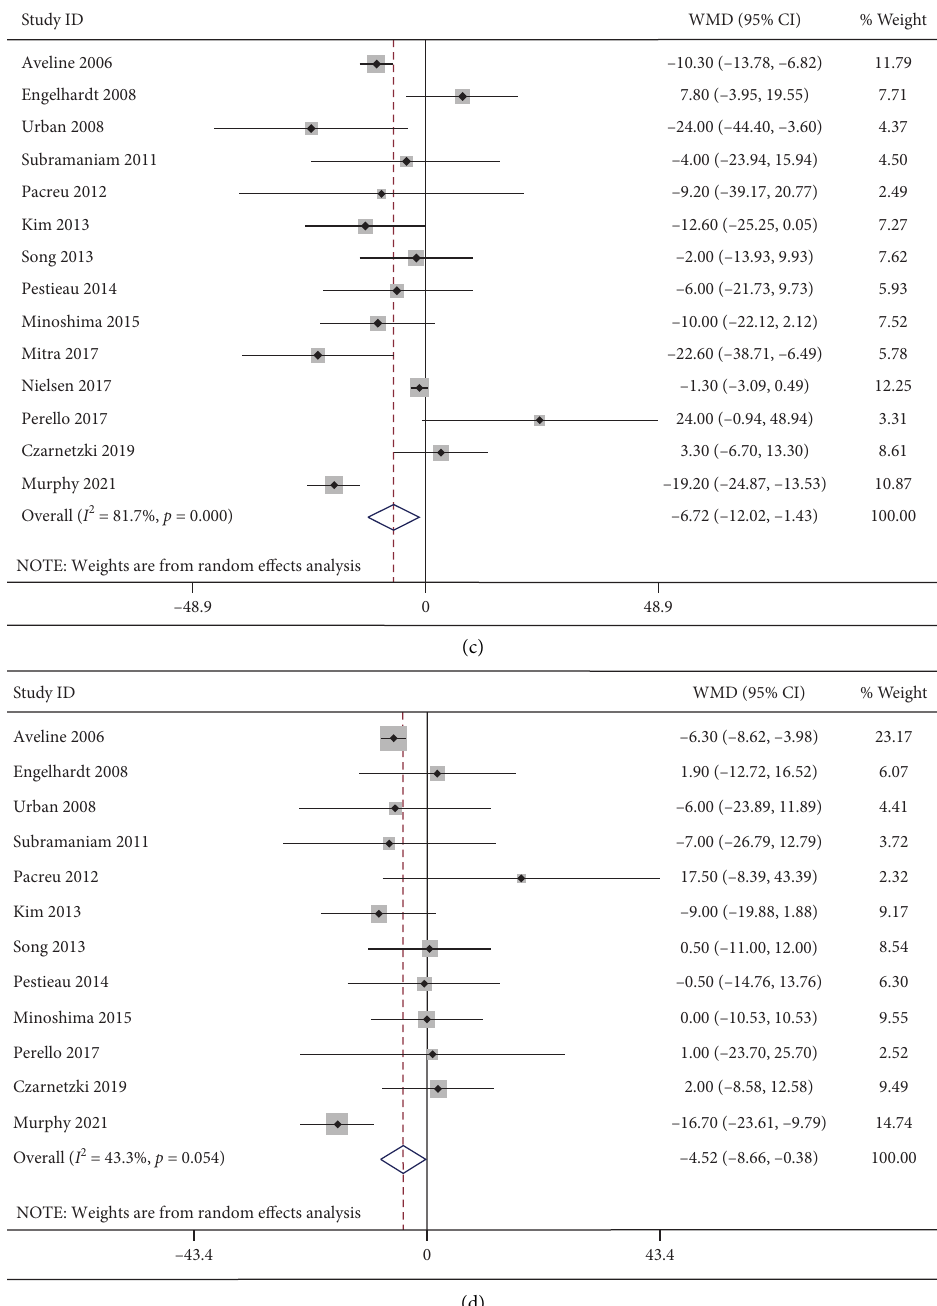
Figure 4: Forest plot of the pain intensity during mobilization for the ketamine group and control group. (a) 6h; (b) 12h; (c) 24h; (d)